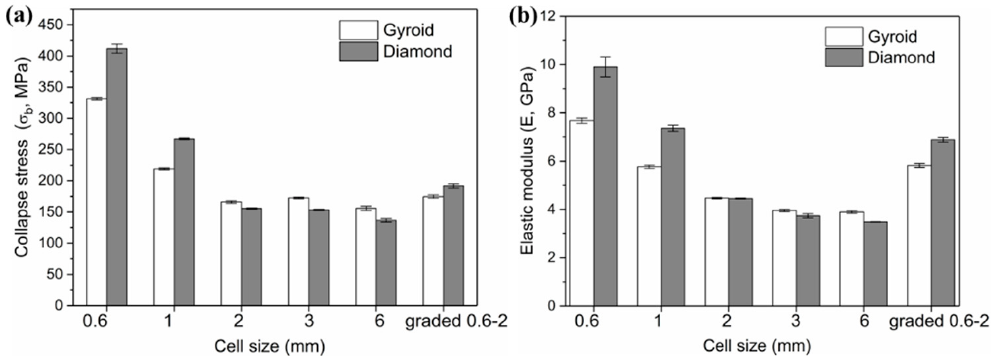
Figure 12. Comparison of ( a ) collapse stress and ( b ) elastic modulus of Gyroid and Diamond scaffolds with cell size ranging from 0.6 to 6 mm, where cell size of 3 and 6 mm are based on Reference [28].